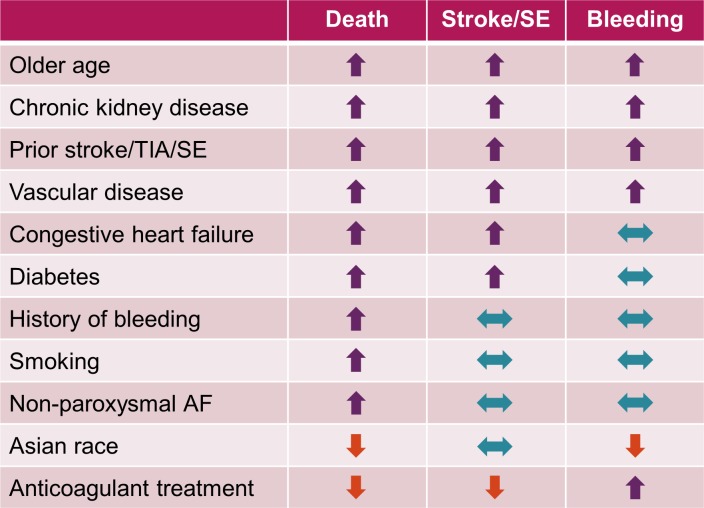
Relationships between variables and clinical outcomes during 2-year follow-up.Key to symbols used: upwards arrow indicates increased risk, downwards arrow indicates reduced risk, double-headed arrow indicates no change in risk. AF, atrial fibrillation; SE, systemic embolism; TIA, transient ischaemic attack.